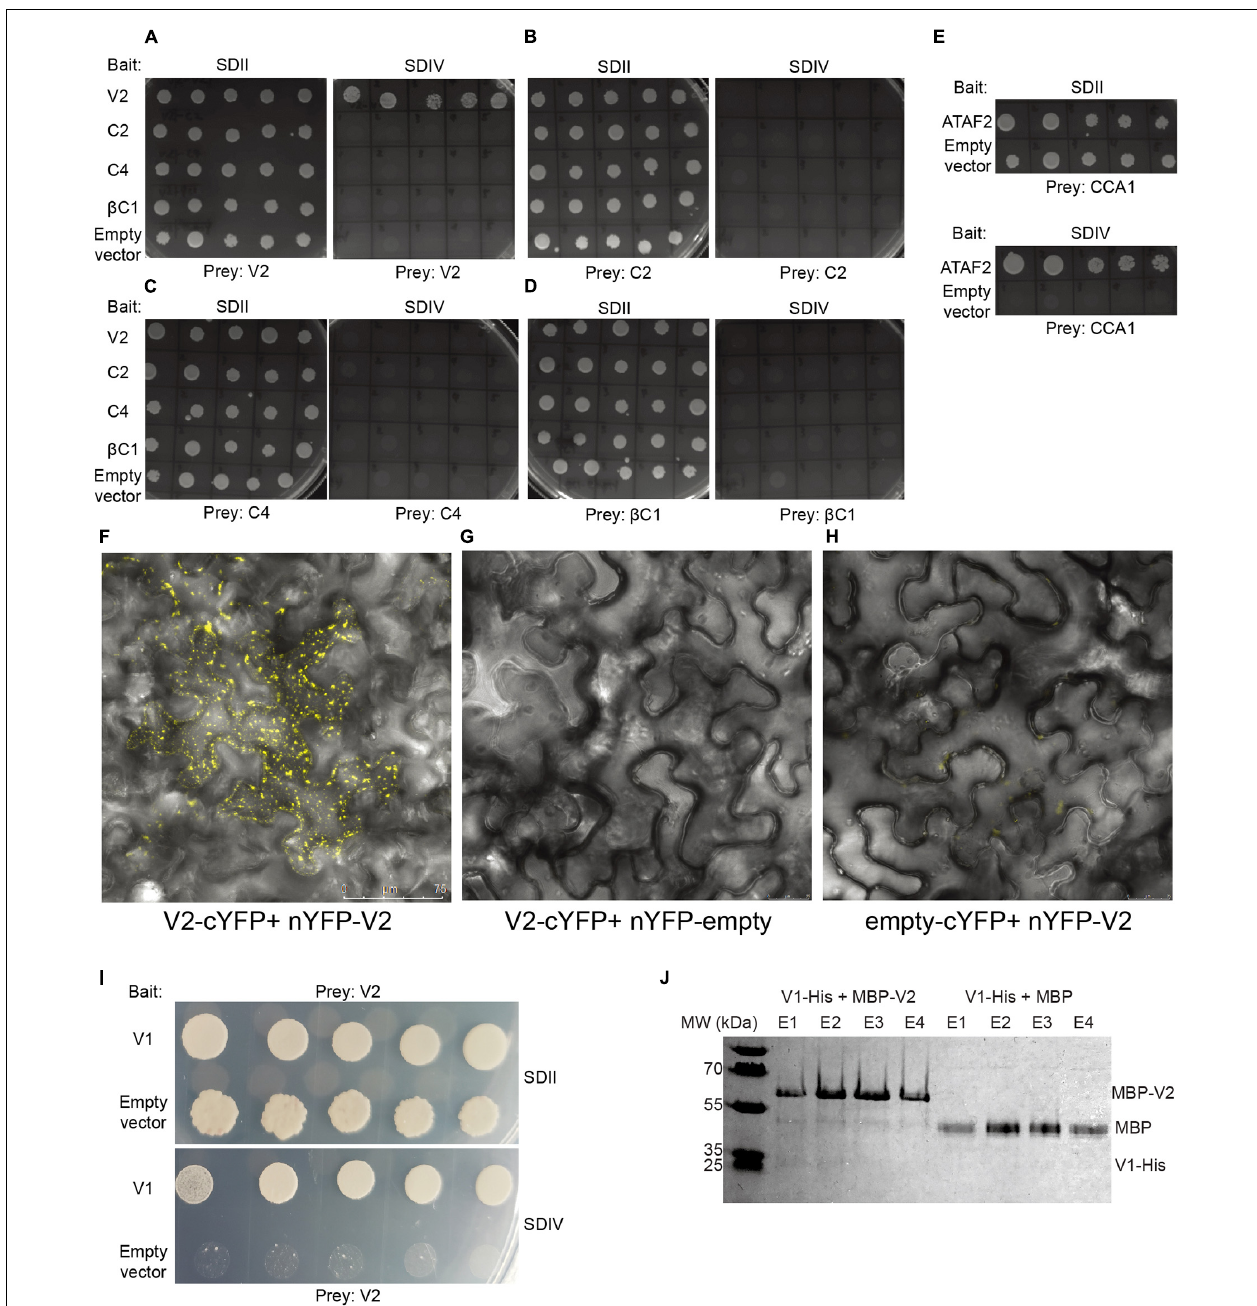
FIGURE 7 | CYVMV V2 physically interacts with itself and V1. When testing the self and mutual interactions among all four silencing suppressors V2 (A) , C2 (B) , C4 (C), and β C1 (D) via targeted Y2H, only V2 exhibits self-interaction. Empty bait vector pBTM116-D9 was used as the negative control. A known interaction between Arabidopsis CCA1 and ATAF2 was used as a positive control (E) . All combinations can grow on SDII plates deprived of leucine and tryptophan, as the bait and prey vectors provide the biosynthesis ability of these two amino acids. Only the positive V2-V2 combination can grow on synthetic dropout IV (SDIV) plates, which indicates their physical interaction. The interaction increases the ability of uracil and histidine biosynthesis in yeast cells and thereby enables their growth on SDIV deprived of uracil, histidine, leucine, and tryptophan. Five independent yeast clones were shown for each combination. Self-interaction of V2 was further confirmed by the in planta bimolecular fluorescence complementation (BiFC) approach. (F) N. benthamiana leaves infiltrated with V2-cYFP + nYFP-V2 constructs showed strong yellow fluorescent signals. As negative controls, no fluorescence was detected in leaves infiltrated with V2-cYFP + nYFP-empty (G) or empty-cYFP + nYFP-V2 (H) . (I) CYVMV V1 and V2 proteins physically interact with each other in a targeted Y2H assay. Five independent yeast clones were shown. (J) V1-V2 interaction was confirmed in a pull-down assay. V1-His + MBP-V2 and V1-His + MBP protein mixtures were loaded to pass through the amylose resin, respectively. After washing away unbound proteins, four rounds of elution (E1-E4) were performed to collect maltose-binding proteins and their interactors. V1-His and MBP-V2 were co-eluted from the amylose resin (E1 and E2). In contrast, the MBP tag protein cannot bind V1-His. YFP, yellow fluorescent protein.